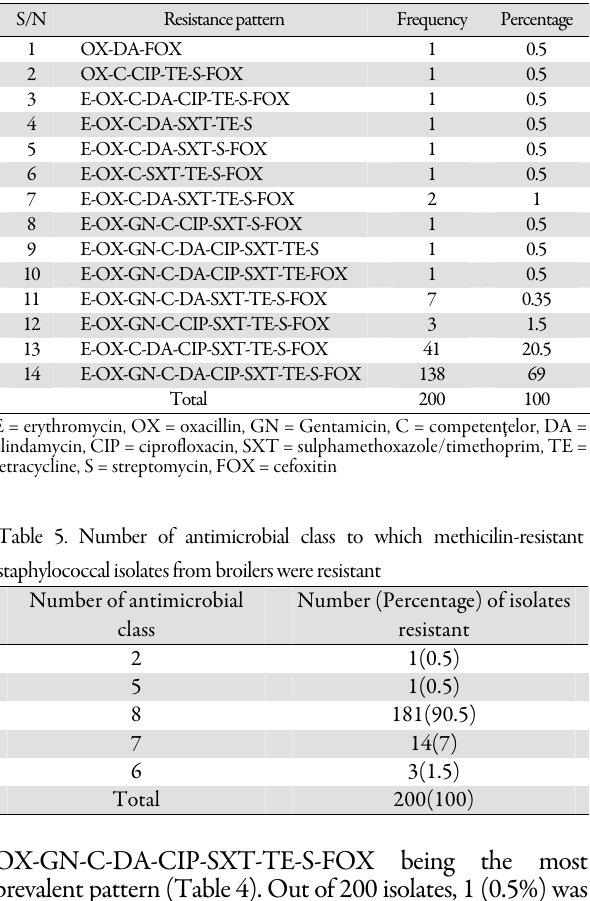
Table 1. Isolation rate of methicillin-resistant staphylococci from broilers Sample Cloaca swab